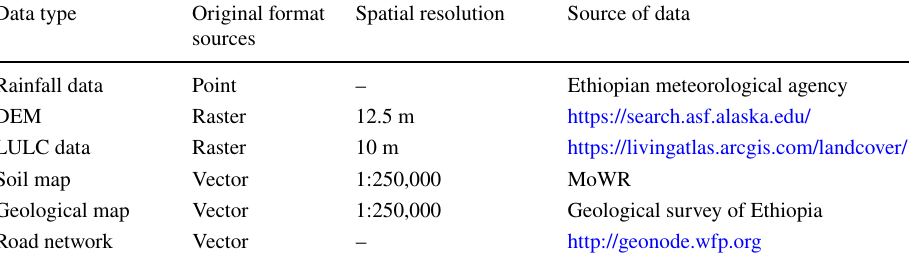
Fig. 1 Location of the study area Table 1 Information of the data sources used in this study